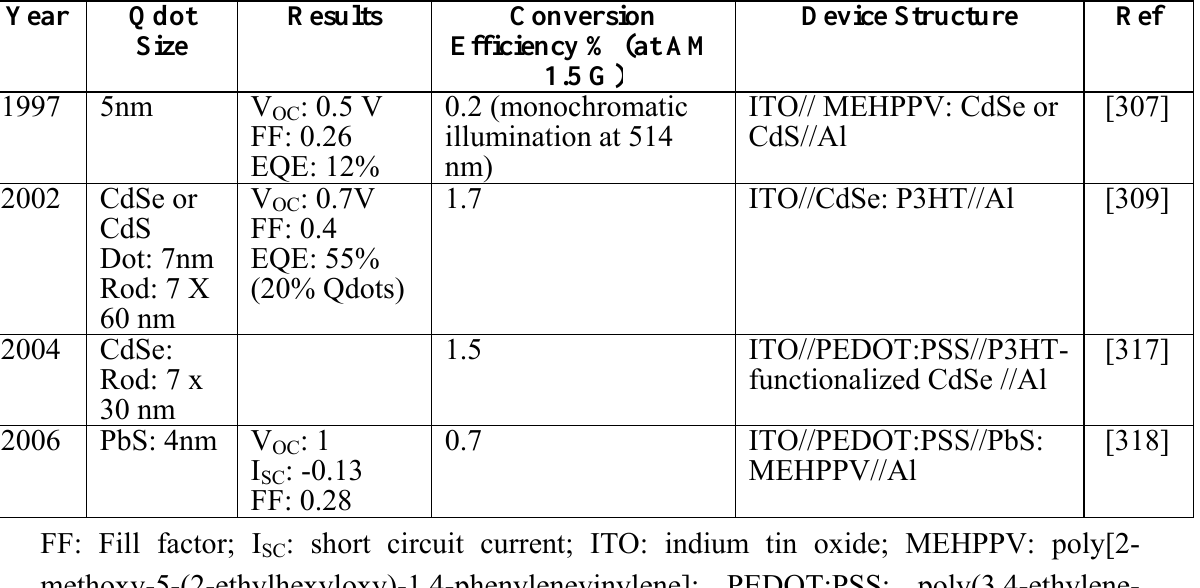
Table 10. Selected results for solar cells using Qdot dispersed in a conducting